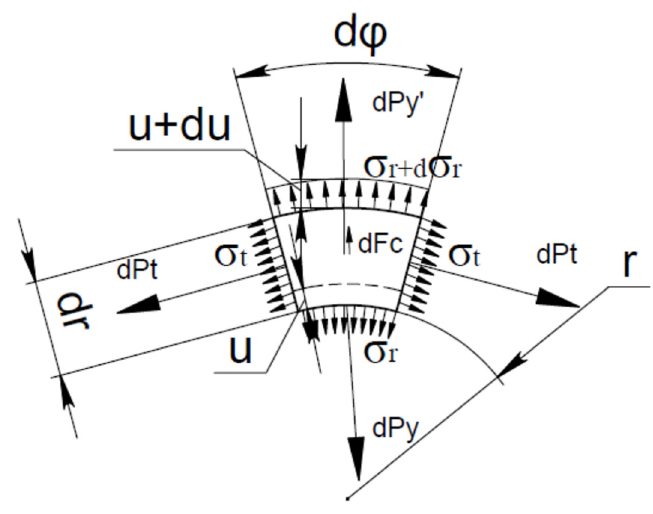
Figure 5. Sketch of the bandage element with loads applied to it.